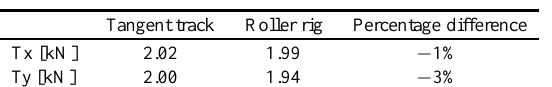
Table 3 Discrepancies between the contact forces yielded by FASTSIM. Only the wheelset mass is